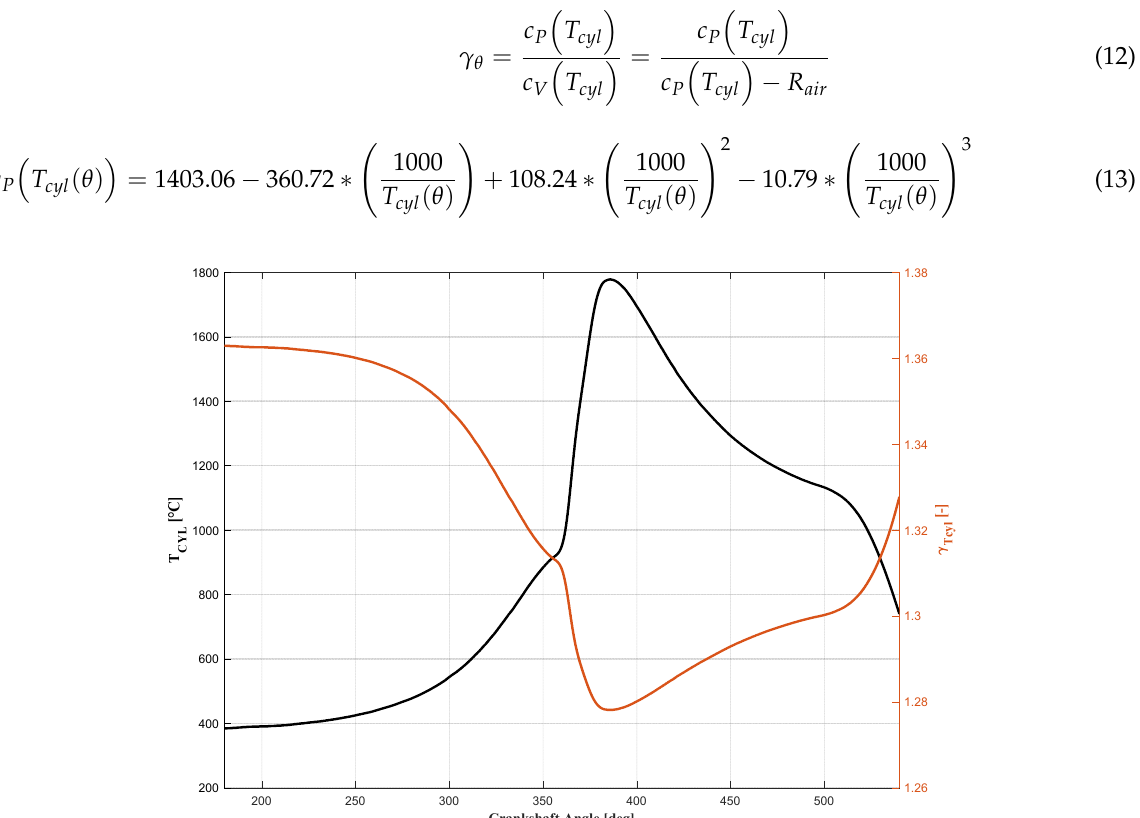
Figure 16. Variation of in-cylinder temperature and γ within the angular interval IVC-EVO.